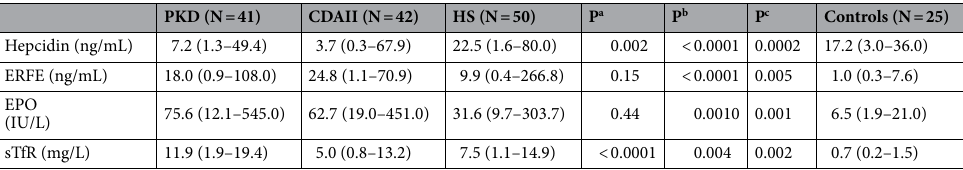
Table 2. Iron homeostasis biomarkers evaluation in patients with PKD, CDAII, and HS. Values are expressed as median (range). P a —PKD vs CDAII patients; P b —CDAII vs HS patients; P c —PKD vs HS patients. Mann– Whitney test.